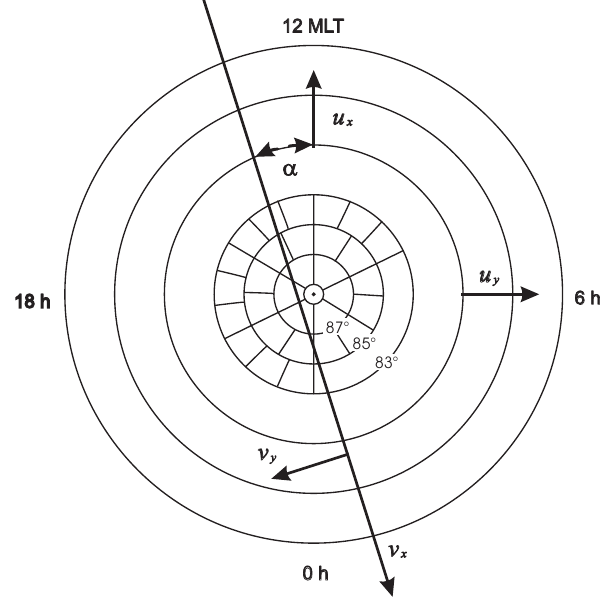
Fig. 1. Schematic illustration of the binning concept. The polar region is divided into concentric rings; each is 2 ◦ wide in latitude. The rings are subdivided further in equal-area sectors. The mea- sured cross-track wind components, v y , from all fly-overs under various angles α are sorted into the bins. The estimated mean wind vectors are presented in SM coordinates by the components u x and u y